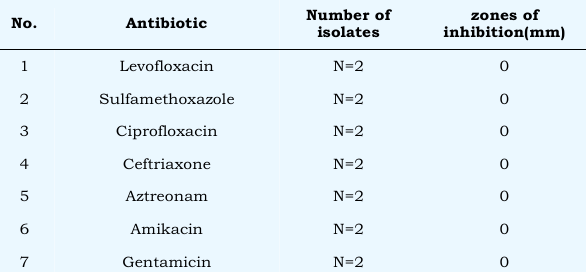
Table 7 Effect of antibiotic types on the growth of Streptomyces sp isolates